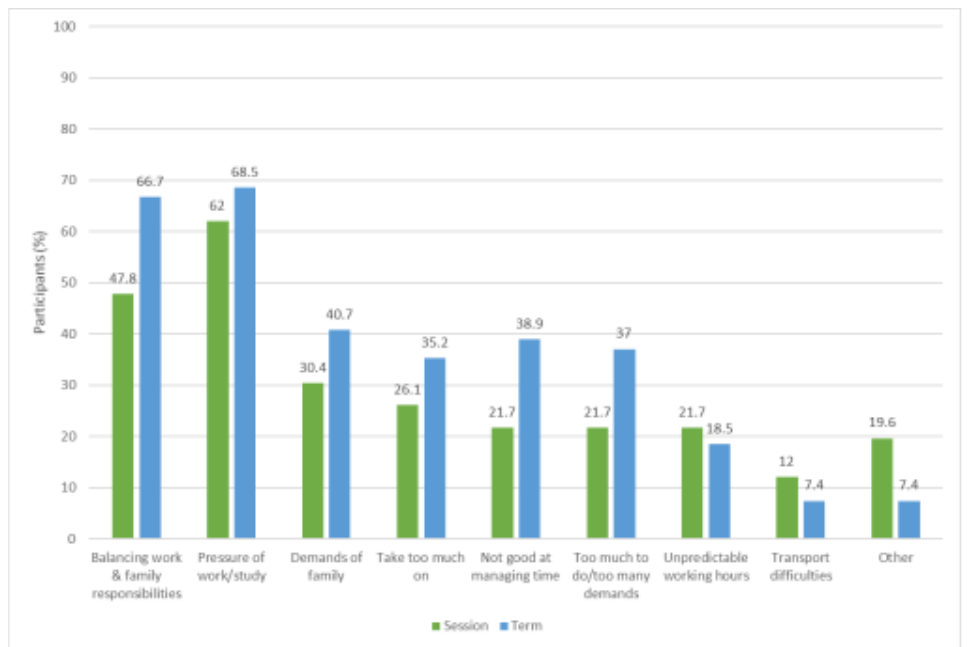
Participants’ Responses Indicating the Reasons for Time pressure in the TDM and the